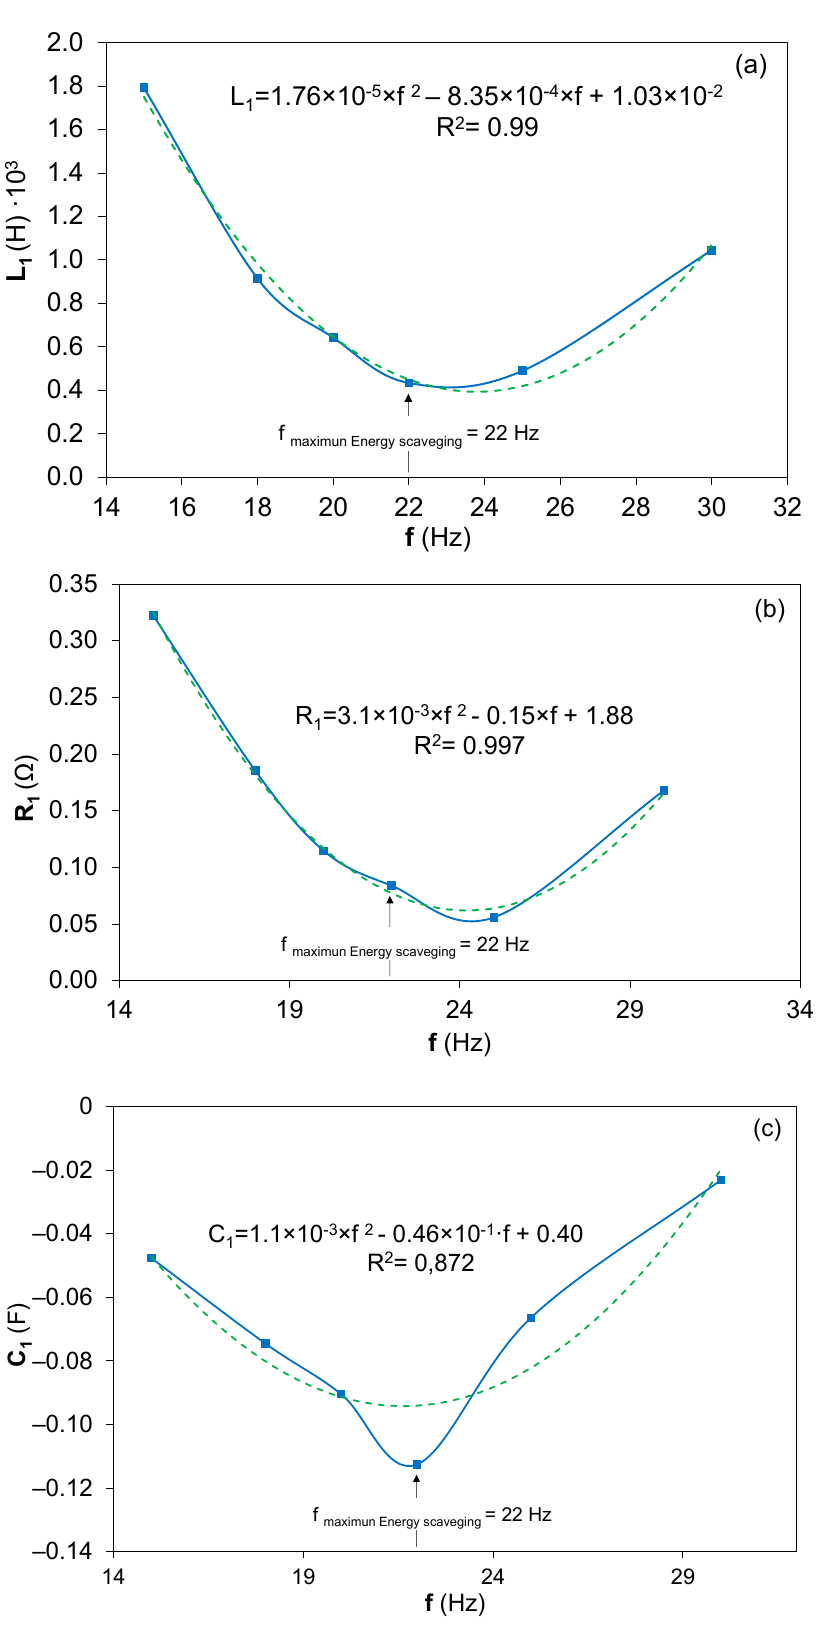
Figure 6. Electrical equivalences of ( a ) the inductance, L 1 , ( b ) the resistance, R 1 , and ( c ) the capaci- tance, C 1 , resulting from the BRM model based on the mechanical experimental results and their fitting into the second-order equation.